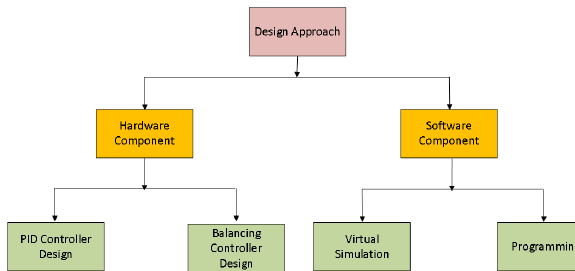
Figure 2. Design Methodology.